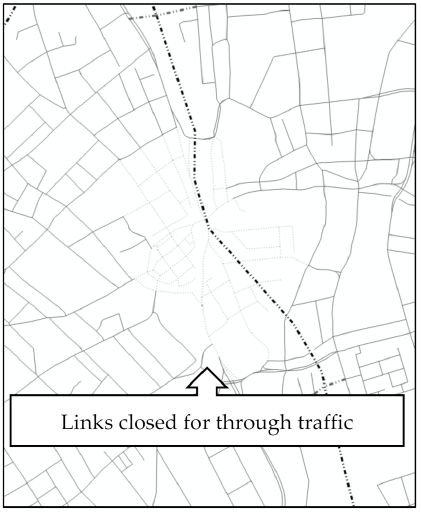
Figure 4. Links closed for through traffic in the central areas of the city.